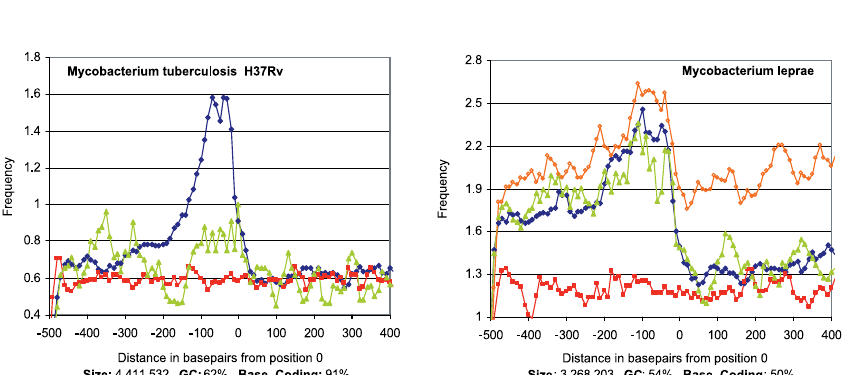
Figure 4. Signal Density in Regulatory versus Nonregulatory Regions of M. tuberculosis and M. leprae M. leprae shows an increase of promoter-like signals in the upstream and downstream regions of pseudogenes relative to the regulatory regions. M. leprae contains over 1,115 recognizable pseudogenes [20]. Both 500 bp upstream and downstream of the start of pseudogenes (position 0) were analyzed for searches of promoter-like signals. All other region definitions and methodology are as in Figure 3.